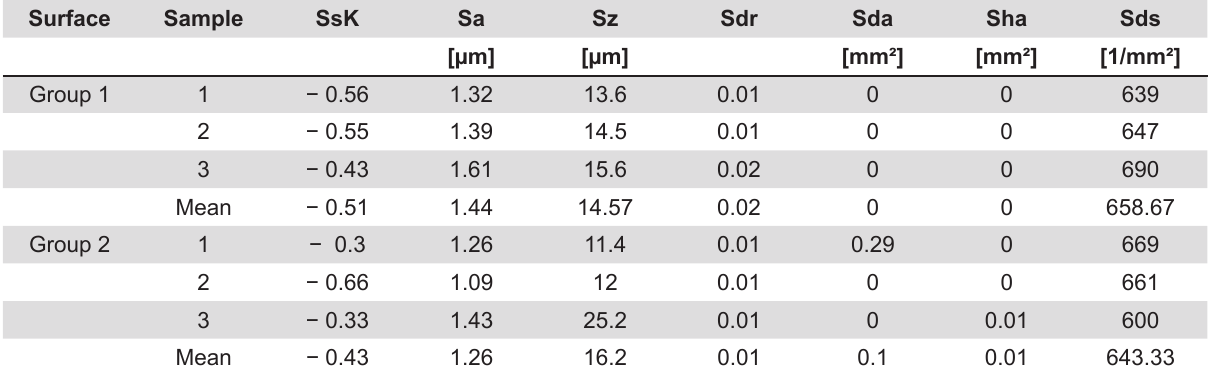
Figure 6- Histomorphometric analysis of (a) Bone area fraction occupied (BAFO) and (b) Mean bone-to-implant contact (BIC). BAFO was calculated as a percentage of the total region among the threads. BIC was calculated as a percentage of the total implant perimeter. Results are shown as mean percentages ± standard deviation. Statistically significant differences are indicated by an asterisk, * p<0.05; ** p<0.01; *** p<0.001 Table 2- Topographic analysis of the implant surface roughness, values obtained from confocal